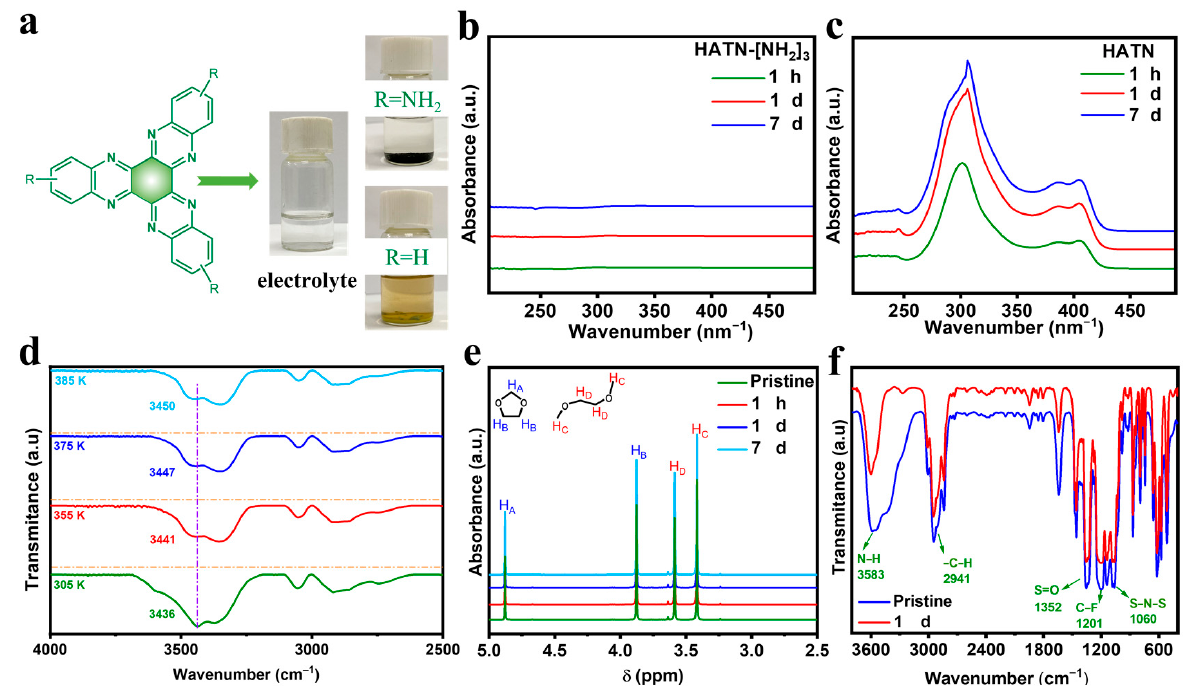
Figure 2. The solubility characterization of HATN-[NH 2 ] 3 and HATN in the electrolyte. ( a ) Digital photos of HATN-[NH 2 ] 3 and HATN in the electrolyte. ( b , c ) UV-vis spectra of the electrolytes after soaking by HATN-[NH 2 ] 3 and HATN for different time intervals, respectively. ( d ) Temperature- dependent in-situ FTIR spectra of HATN-[NH 2 ] 3 . ( e ) 1 H NMR and ( f ) FT − IR spectra of the electrolytes soaked by HATN-[NH 2 ] 3 for different time intervals (pristine: freshly prepared active materials without any treatment).